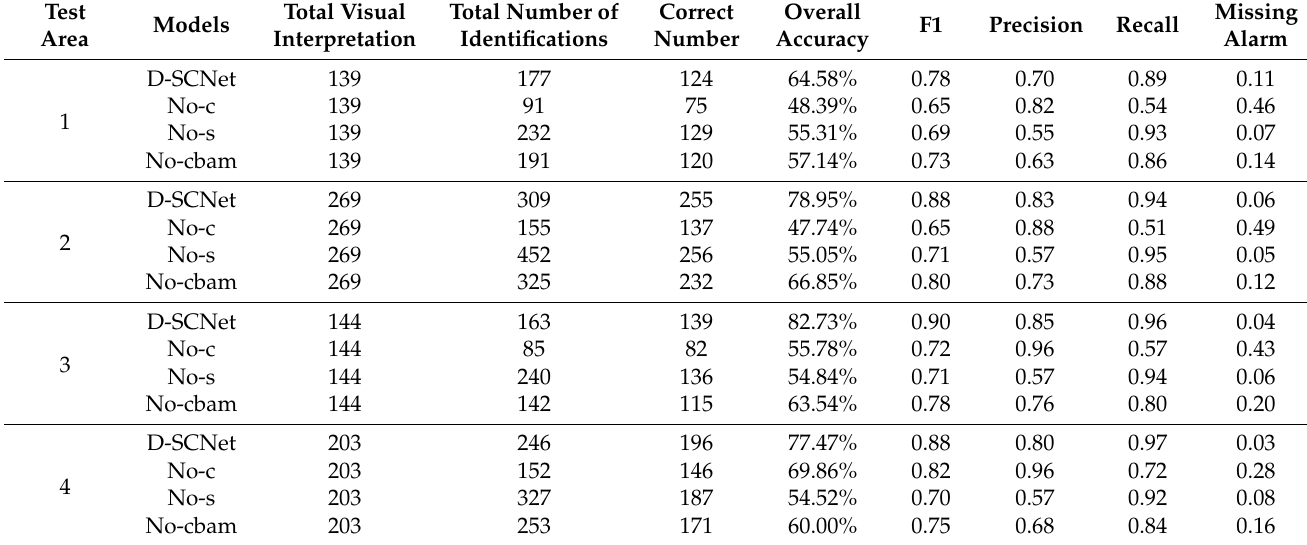
Table 6. Accuracy evaluation of ablation experiments.